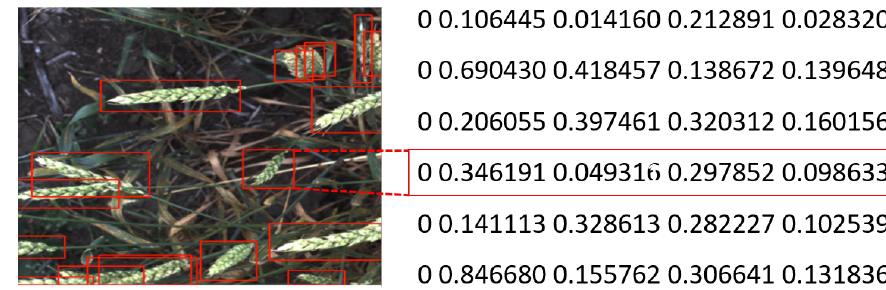
Figure 4. The visual depiction of sample annotated image from training